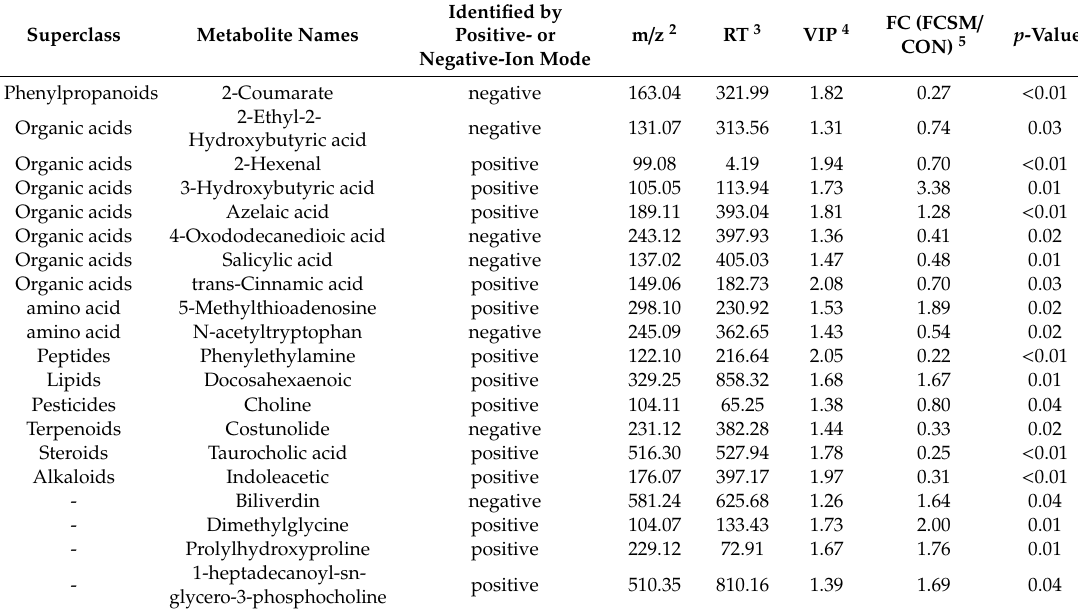
Table 6. Identification of significantly di ff erent metabolites in serum between the CON and FCSM groups 1 .